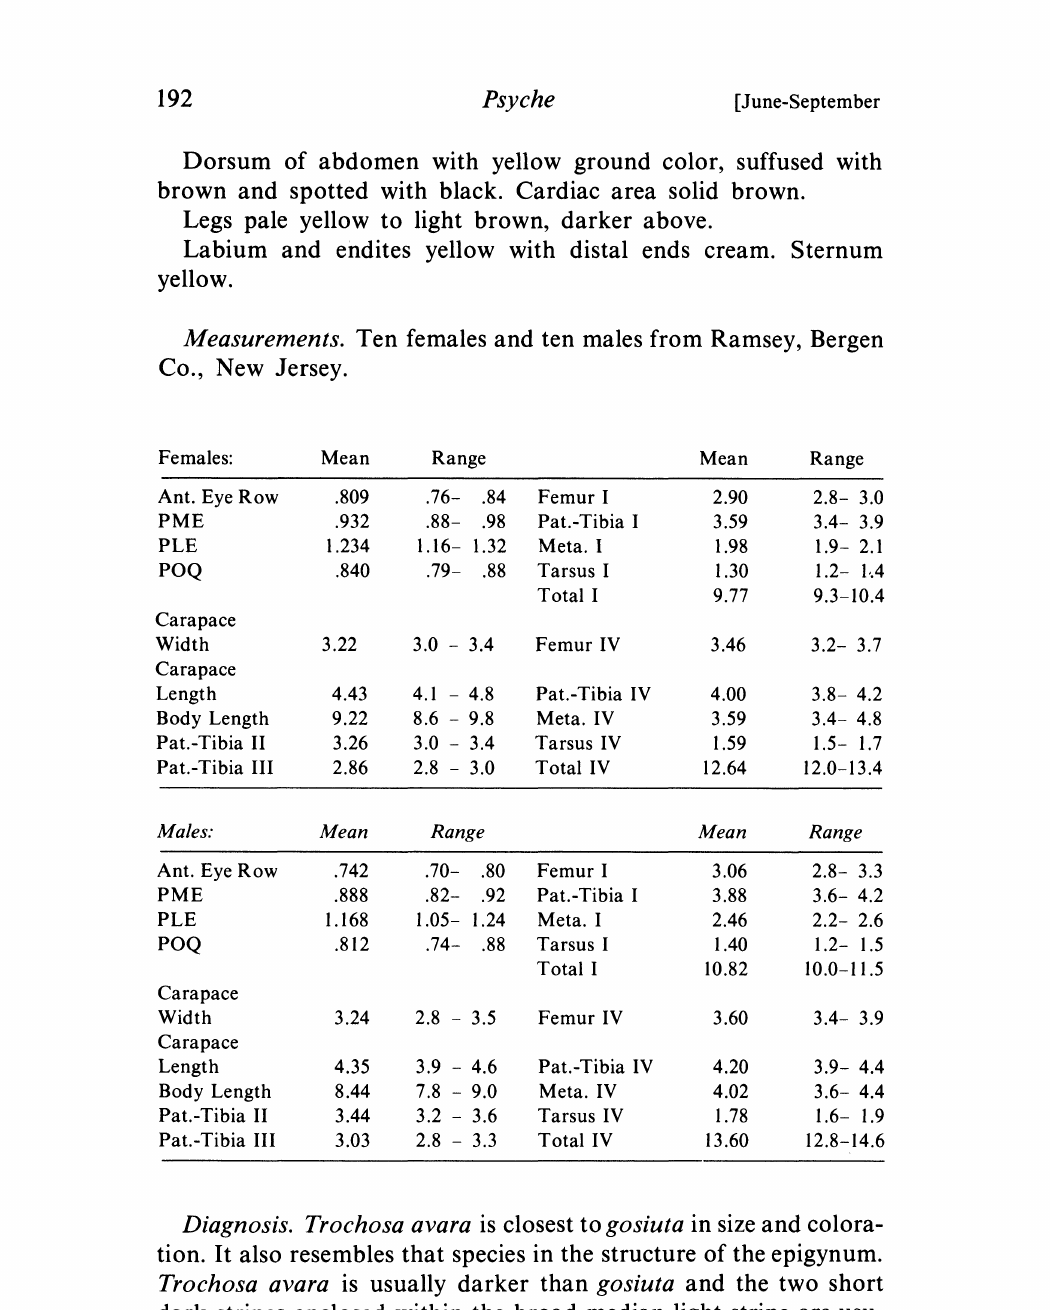
Diagnosis. Trochosa avara is closest to gosiuta in size and colora- tion. It also resembles that species in the structure of the epigynum. Trochosa avara is usually darker than gosiuta and the two short dark stripes enclosed within the broad median light stripe are